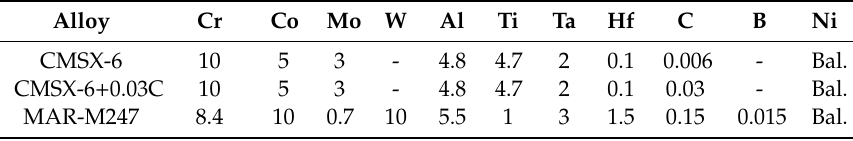
Table 1. Chemical composition of the employed Ni-based superalloys in wt.%. Alloy Cr Co Mo W Al